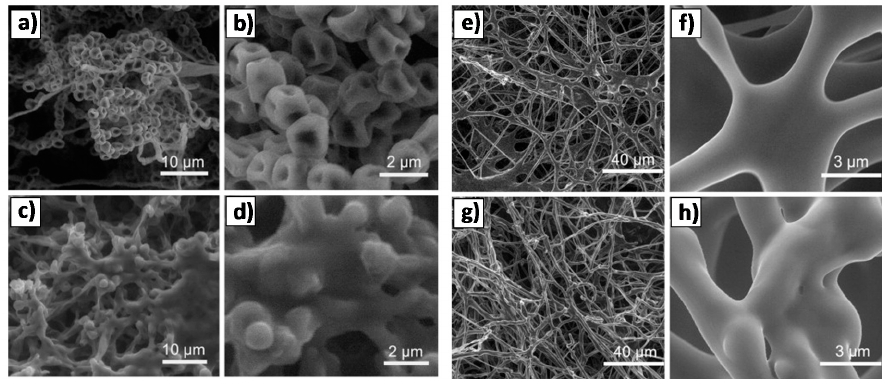
Figure 10. SEM images of ( a – d ) Penicillium expansum and ( e – h ) Botrytis cinerea without ( a , b , e , f ) or with ( c , d , g , h ) the treatment of ZnO QDs suspension. Reproduced with permission from [97]. Elsevier, 2011.